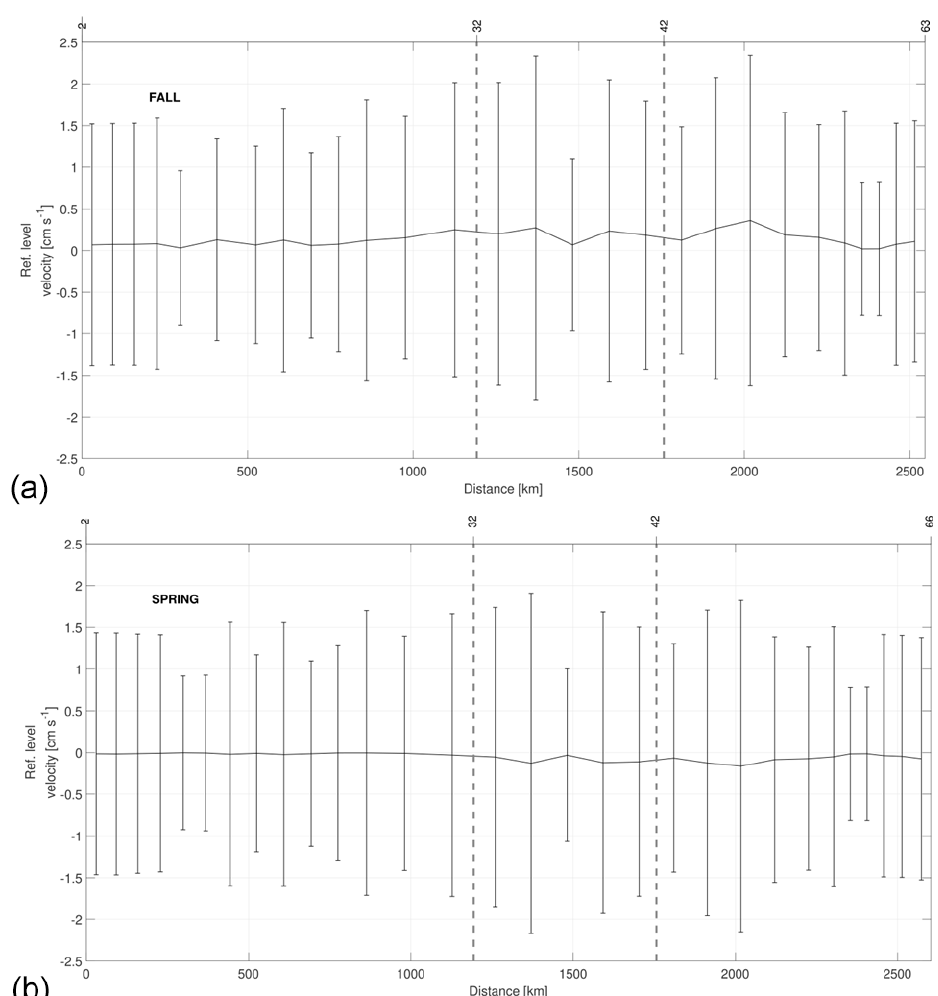
Figure 9. Reference-level velocity at 27.962kgm − 3 and its standard deviation estimated by the inverse model during fall (a) and spring (b) . The direction chosen for the representation is the same as in Fig. 2. The signs of the velocity are according to the geographical criterion; i.e., the velocities are positive–negative toward north–south in the northern and southern transects, and they are positive–negative toward east–west in the western